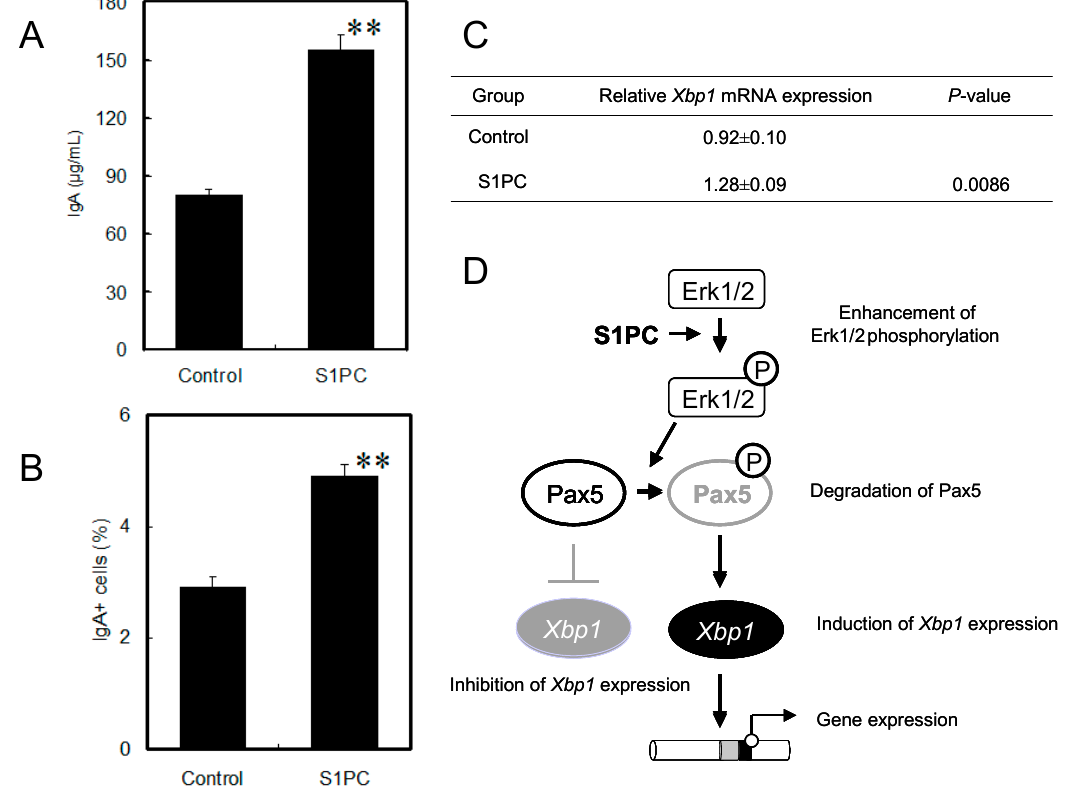
Figure 4. Immunomodulatory effect of S -1-propenyl- L -cysteine. ( A ) Effect of S1PC on IgA levels in intestinal lavage fluid. S1PC (30 mg/kg, once a day) or distilled water were orally administrated